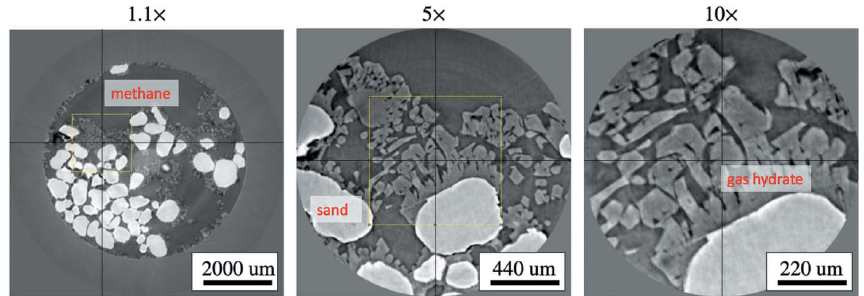
Figure 6 Reconstructed z -slices taken after real-time 3D zooming to the region of interest with formed gas hydrates. Rotation speed and exposure time were adjusted for each magnification change. The reconstruction procedure also involved phase-retrieval and circular mask